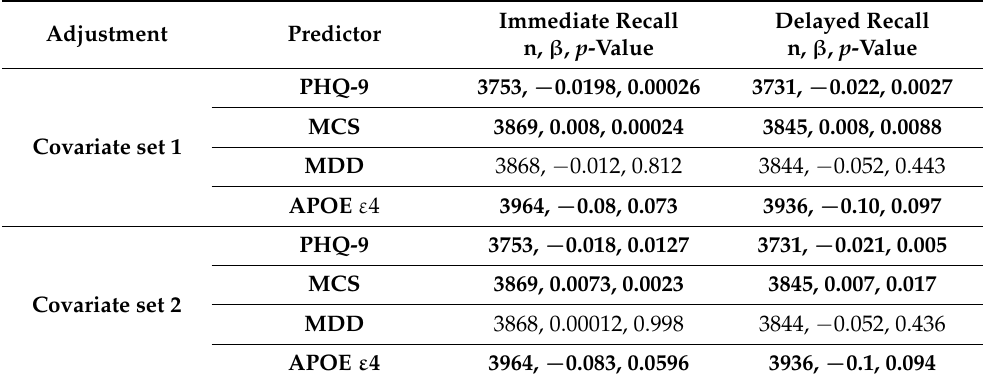
Table 2. Direct effects of depression variables and APOE ε 4 status on the endpoint verbal memory (NAI) in TREND under the adjustment of two different covariate